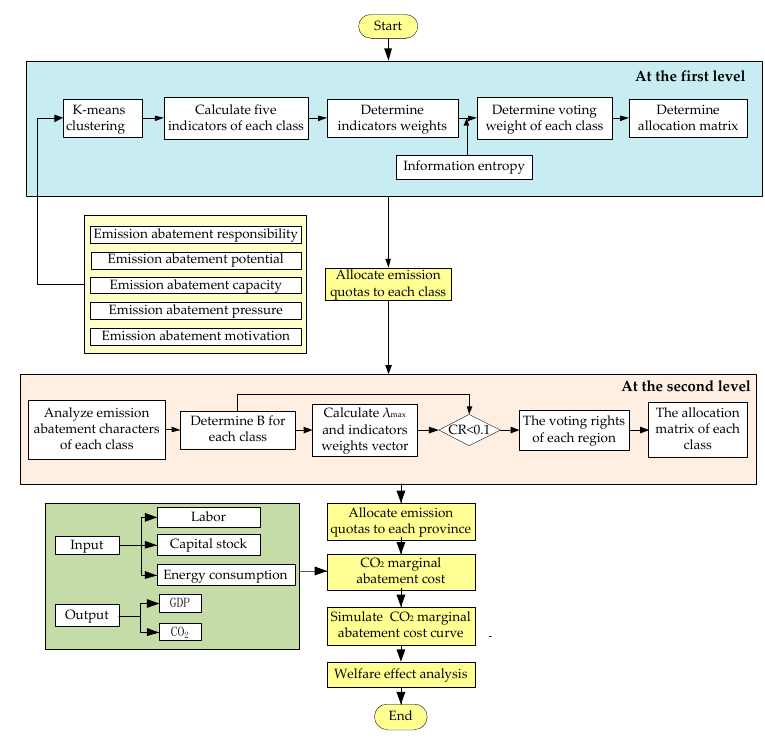
Figure 1. Research framework.